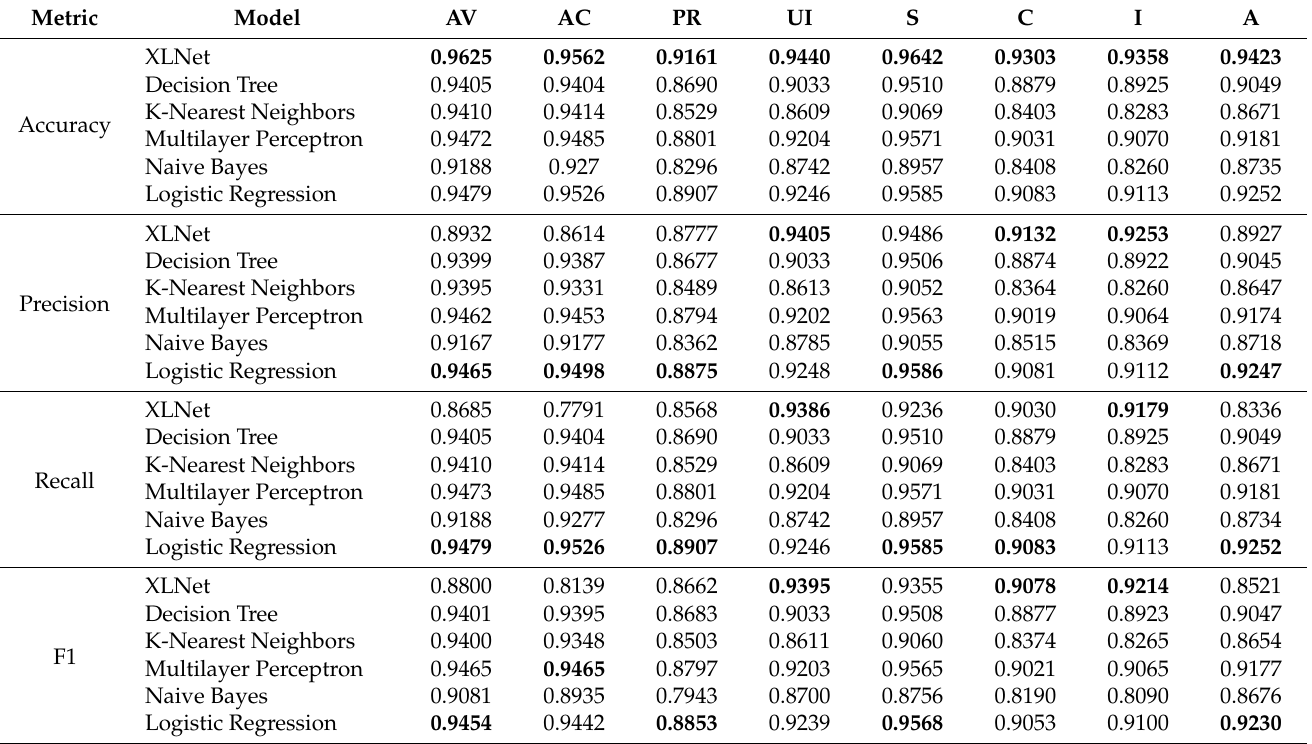
Table 6. The effect of traditional machine learning models and fine-tuned XLNet on the CVSS v3 dataset.